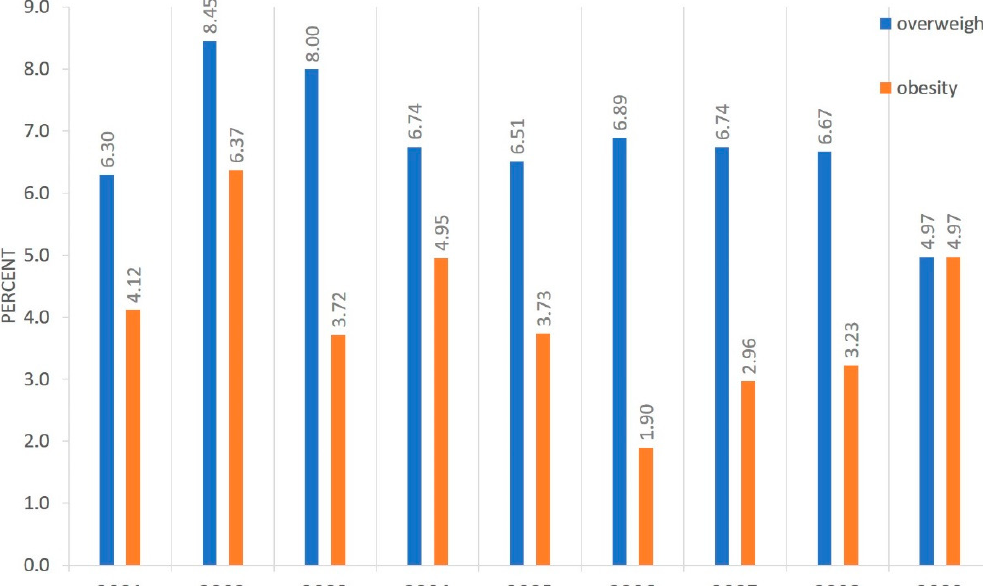
Figure 3. Prevalence of overweight and obesity in boys at age 6–7 by birth year.